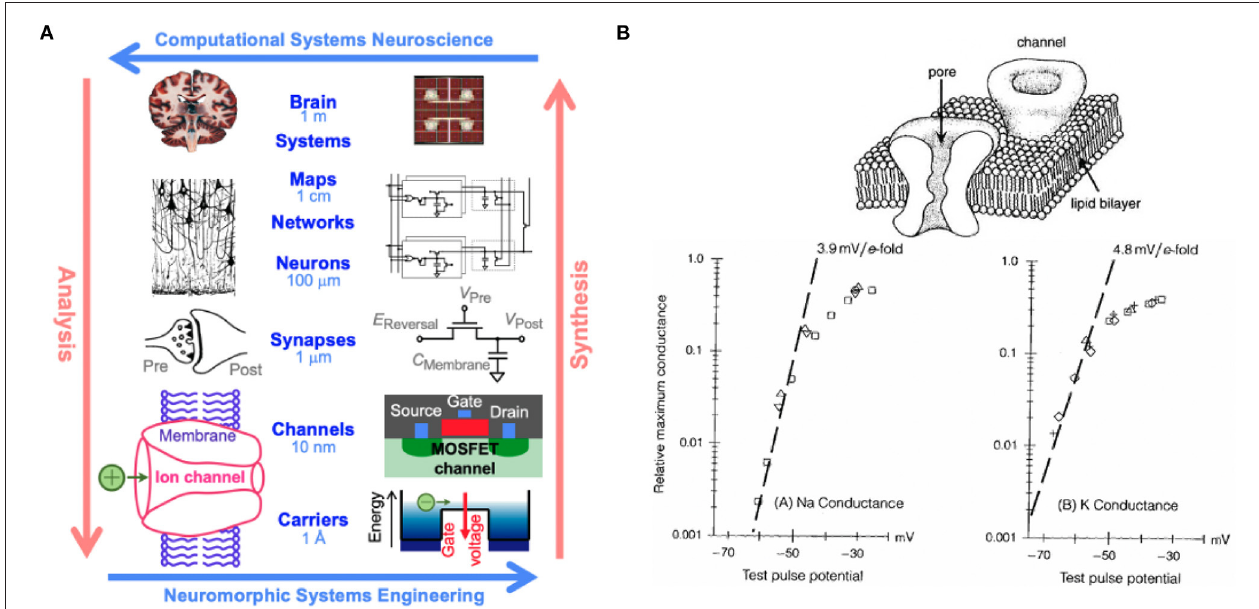
FIGURE 1 | (A) Multiscale correspondence between the fields of computational neuroscience and neuromorphic engineering. Reproduced with permission from Churchland and Sejnowski (1992) and Cauwenberghs (2013) and (B) equivalence in Boltzmann thermodynamics between metal-oxide-semiconductor field-effect transistors (MOSFETs) and ion channels resulting in current as an exponential function of applied voltage in both systems for sodium (bottom left) and potassium (bottom right) ( Hodgkin and Huxley, 1952; Mead,